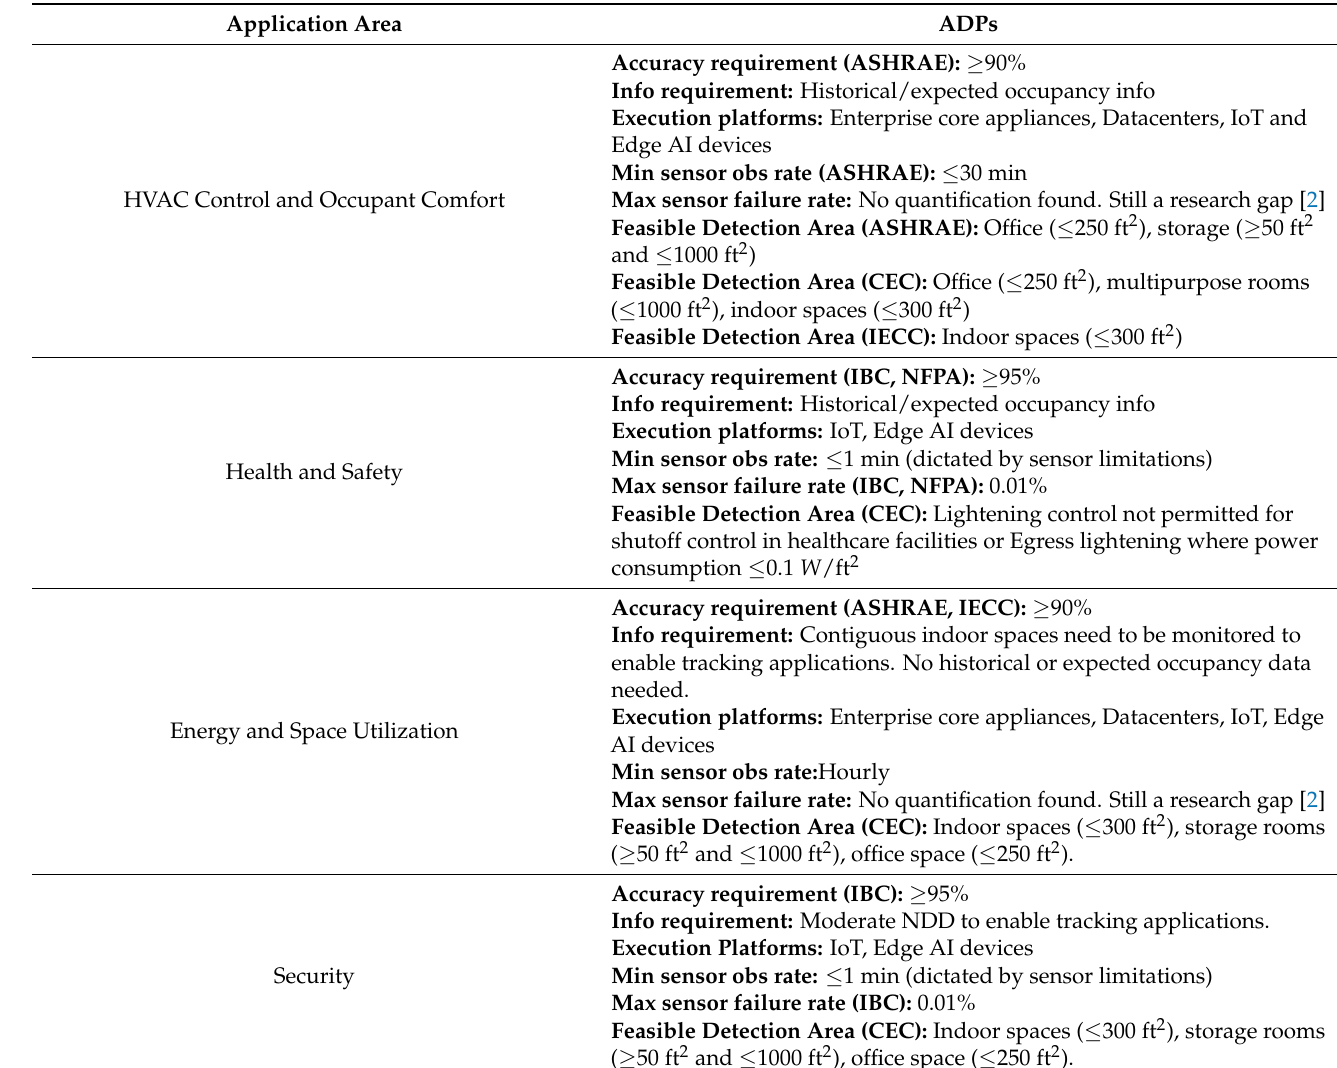
Table 3. ADPs for each Application